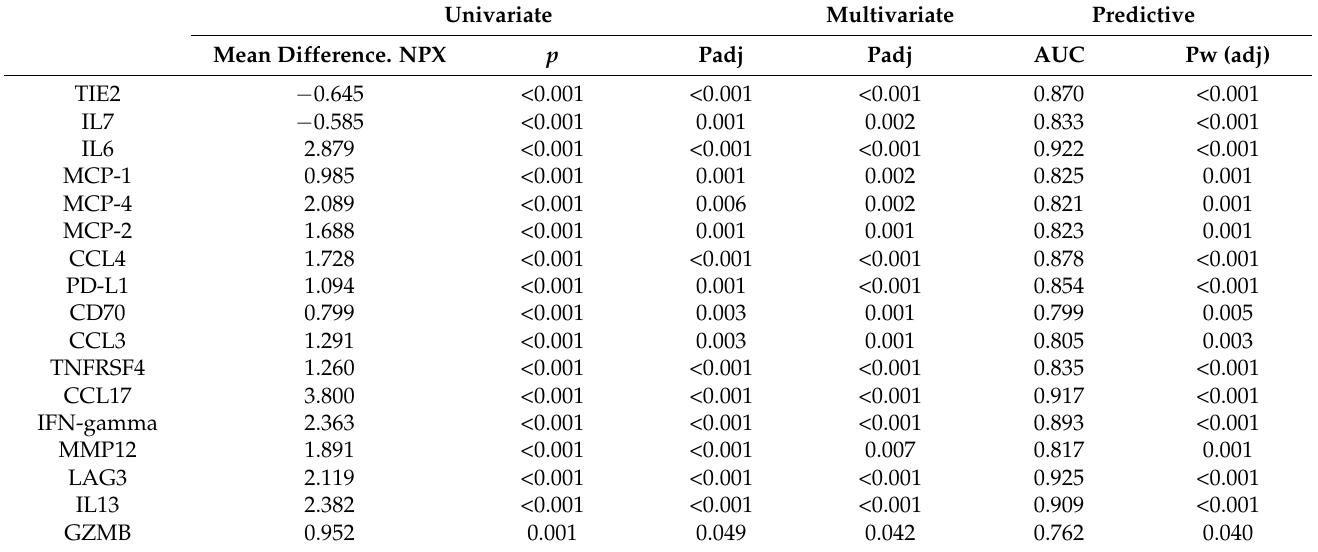
Table 2. Proteins with significant differences in cHL tumor tissue versus control